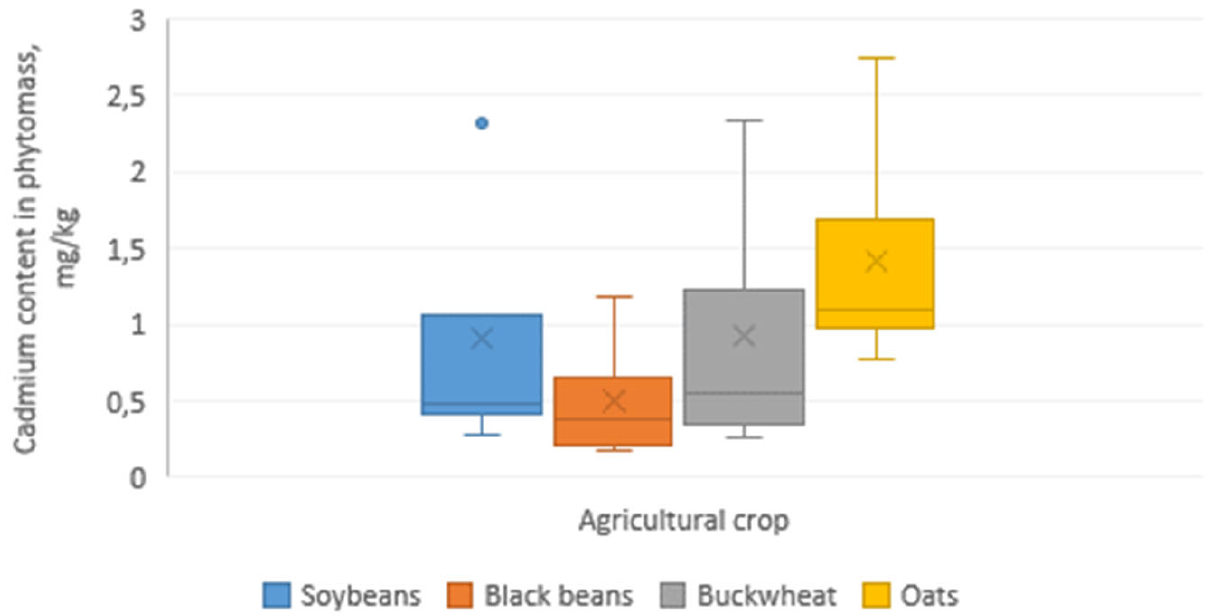
Figure 4. Diagram of cadmium content in the phytomass of test crops on the variants of the vegetation experiment depending on the values of the total indicator of soil contamination.